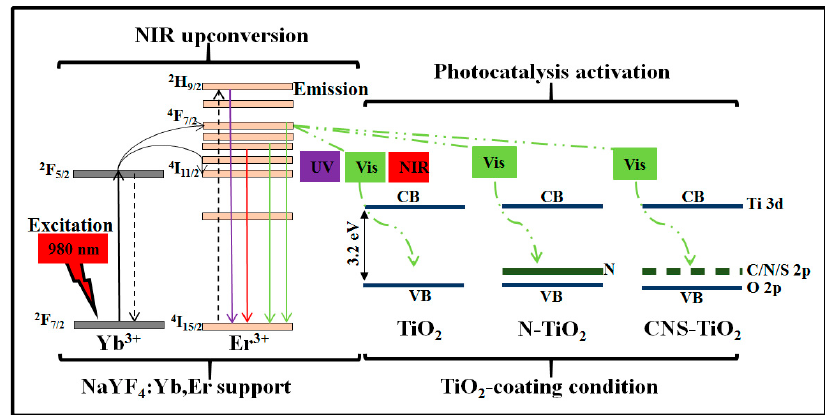
Figure 12. Proposed photocatalysis mechanism for the NaYF 4 :Yb,Er phosphor coated with TiO 2 under different doping conditions.